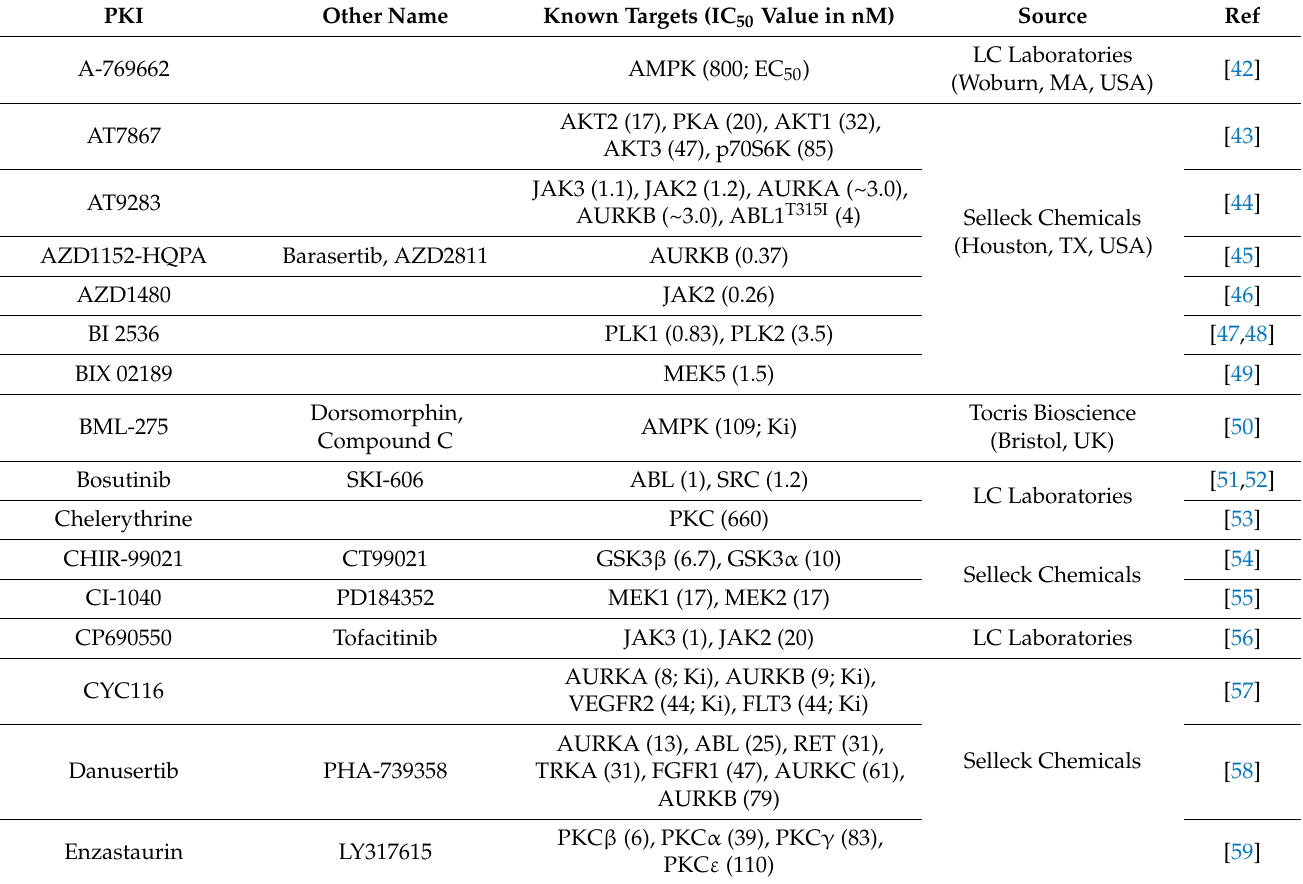
Table 1. Protein kinase inhibitors (PKIs) used in 3-(4,5-dimethylthiazol-2-yl)-2,5-diphenyltetrazolium bromide (MTT) screening.